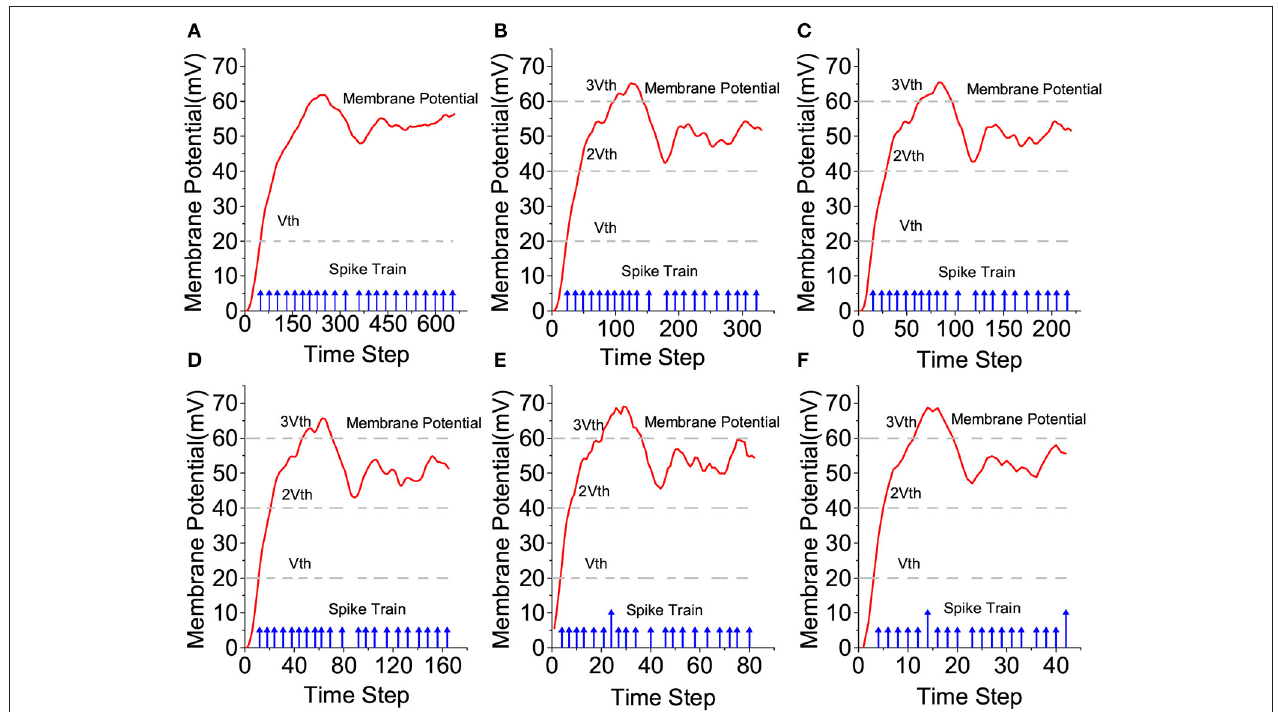
FIGURE 9 | Comparison of LIF and IOW-LIF neurons. (A) No compression, (B) 2:1 compression, (C) 3:1 compression, (D) 4:1 compression, (E) 8:1 compression, and (F) 16:1 compression.